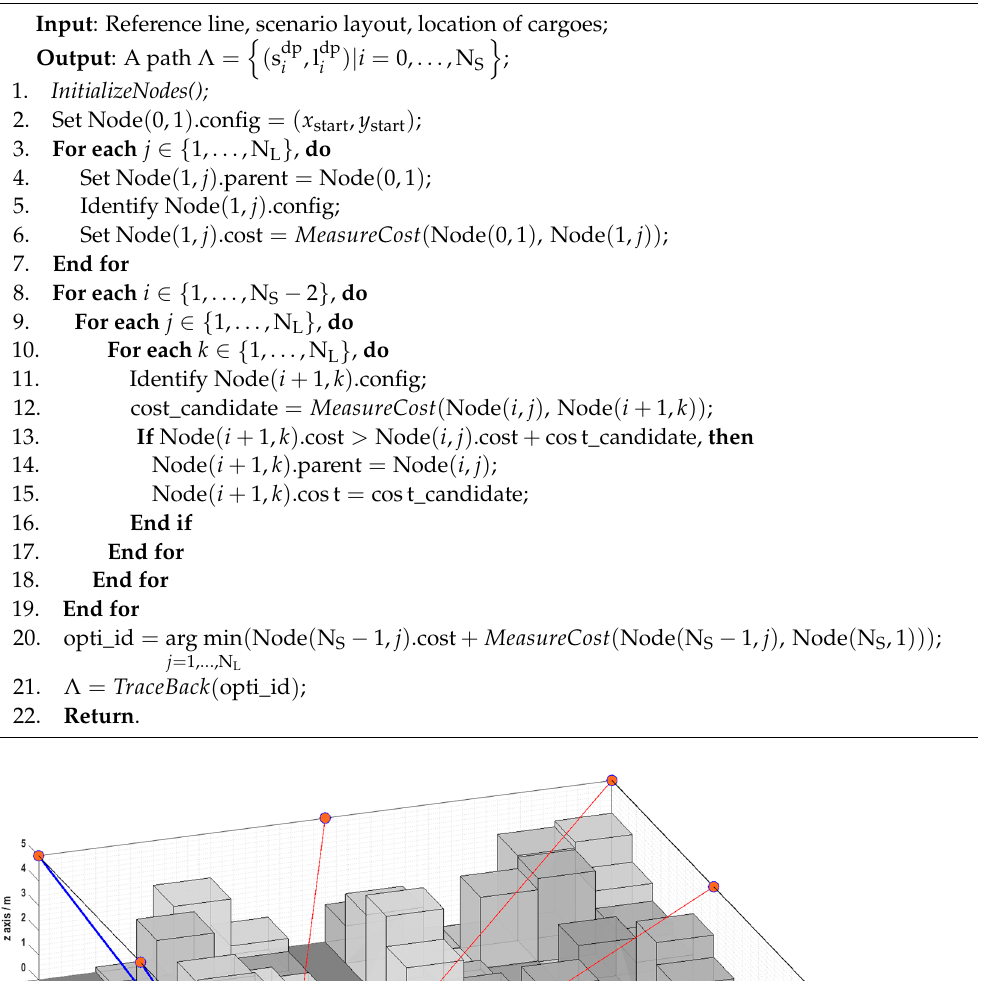
Algorithm 1. Path planning via DP search.